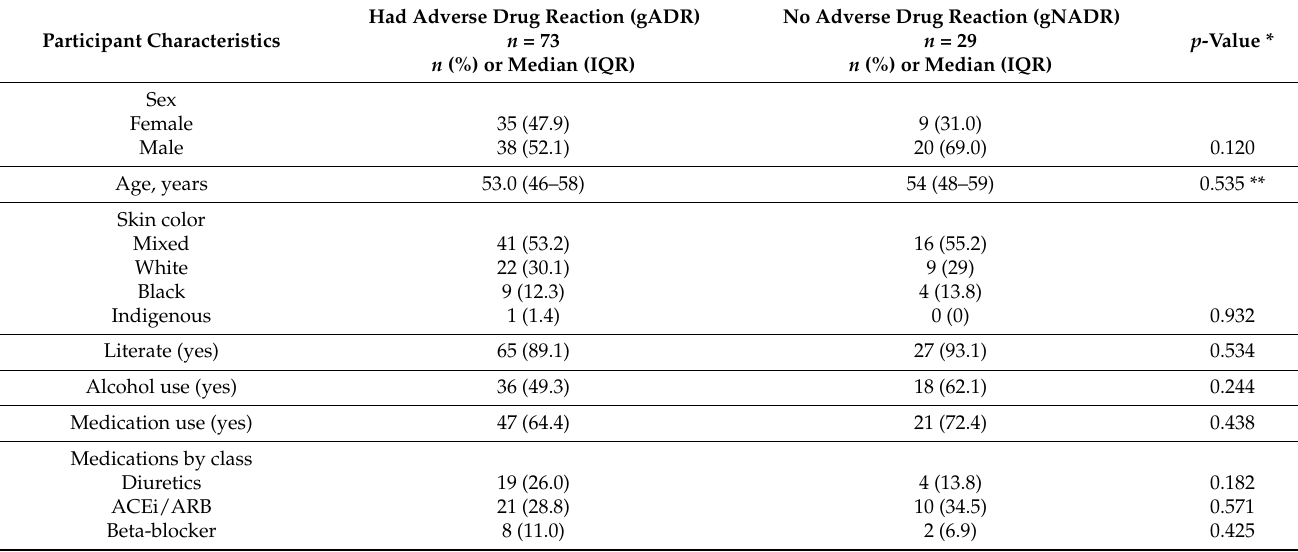
Table 1. Demographic and clinical characteristics of Chagas disease patients treated with benznidazole and stratified according to the development (or not) of adverse drug